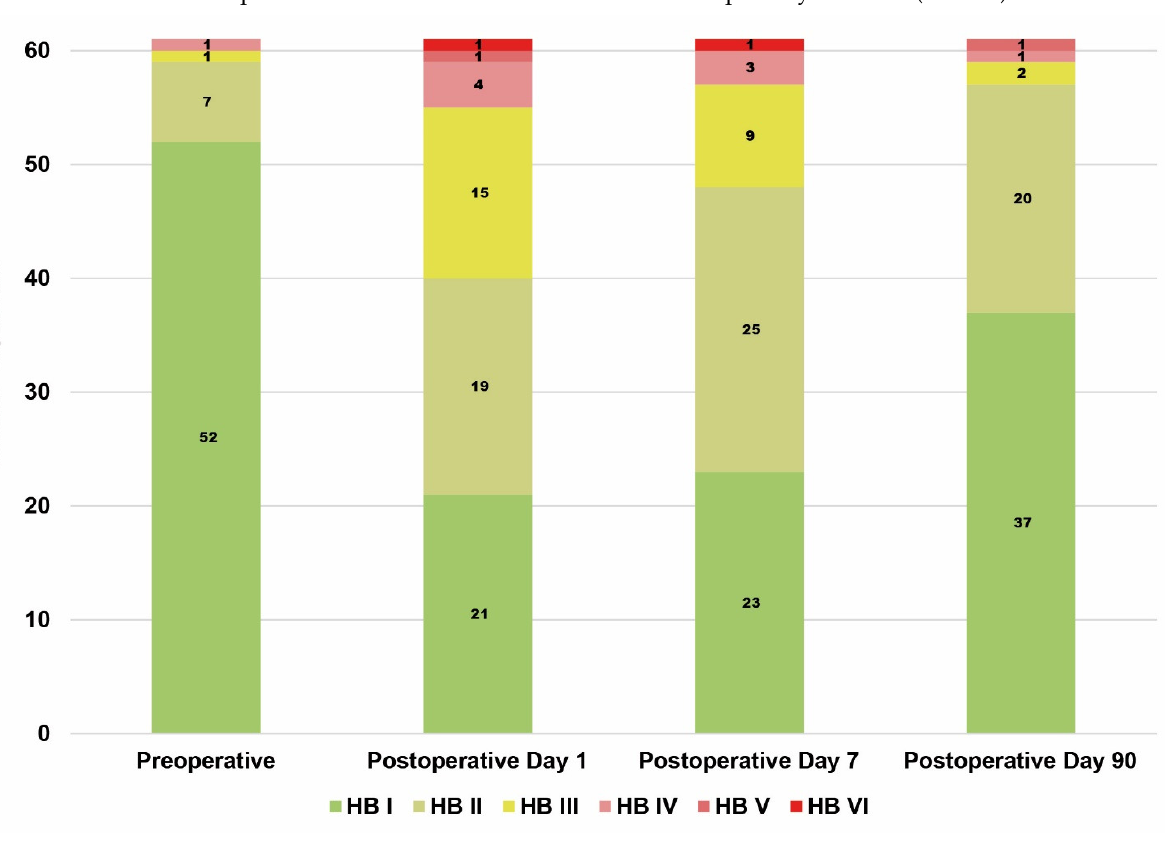
Figure 1. Time plot of facial muscle function. Absolute number of House–Brackmann (HB) scores at each time point are listed inside each bar. Table 3. Patient data.